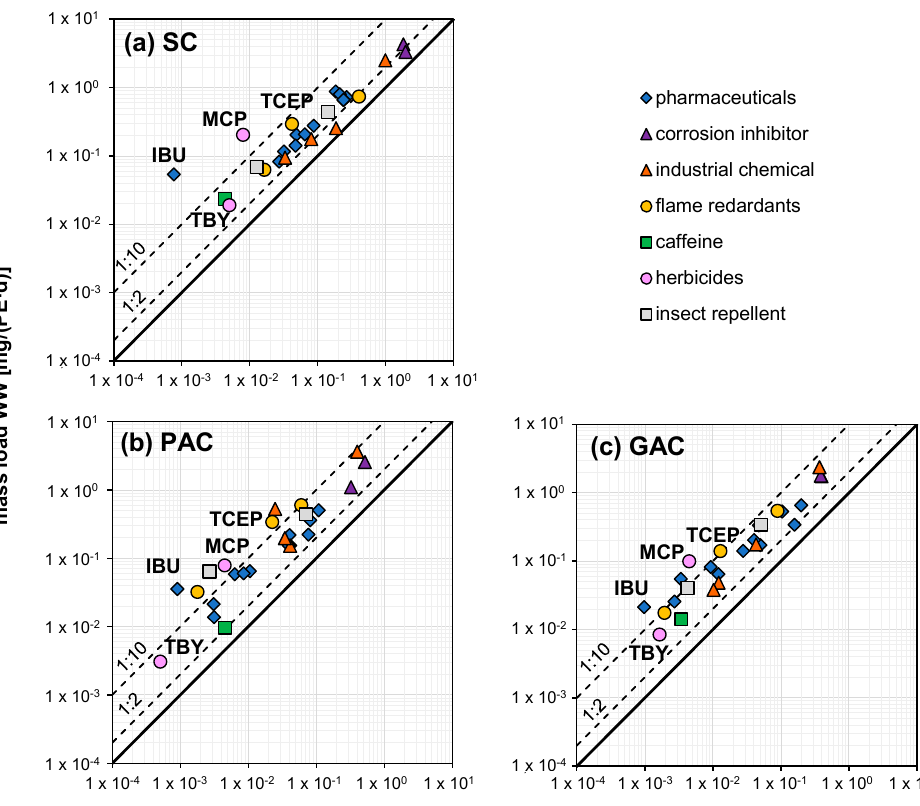
Figure 6. Comparison of the daily mass load related to the population equivalent (PE) per day of OMPs at dry-weather conditions with the mass load at wet-weather conditions WW2 for ( a ) effluent of the secondary clarifier, ( b ) effluent of powdered activated carbon treatment stage and ( c ) effluent of granular activated carbon filter, calculated with the flow rate at S1.